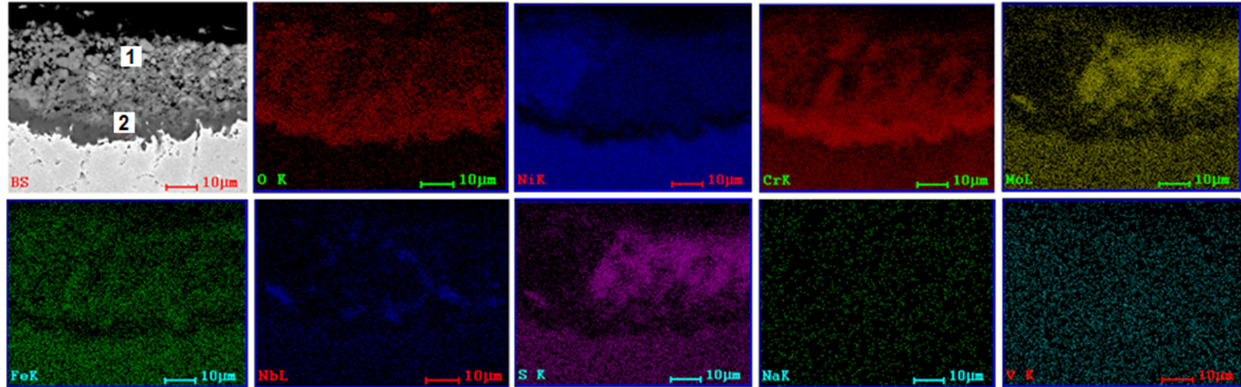
Figure 7. SEM image (BS) and EDS distribution maps of the elements corresponding to SEM image for cross section of 3DPP (1000 °C, 8 h).